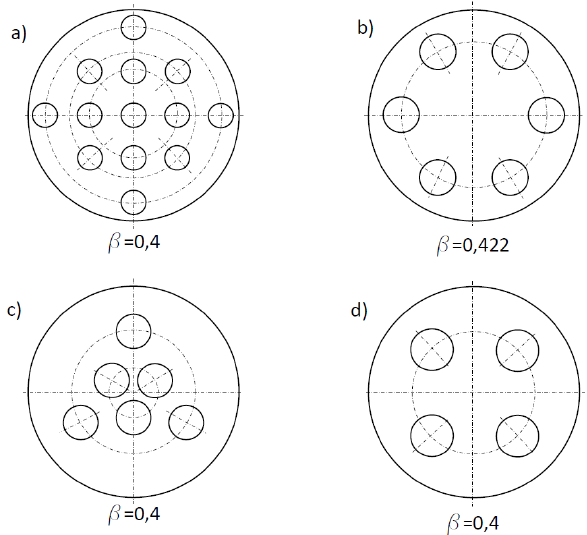
Figure 1: Example of multi-nozzle flanges a) 13-hole flange analyzed by Malavasi et al. , B) 6-hole flange designed by Huang c) example of the flange analyzed by Zhao et al d) flange used by Emerson Rosemount in its gauges [5]